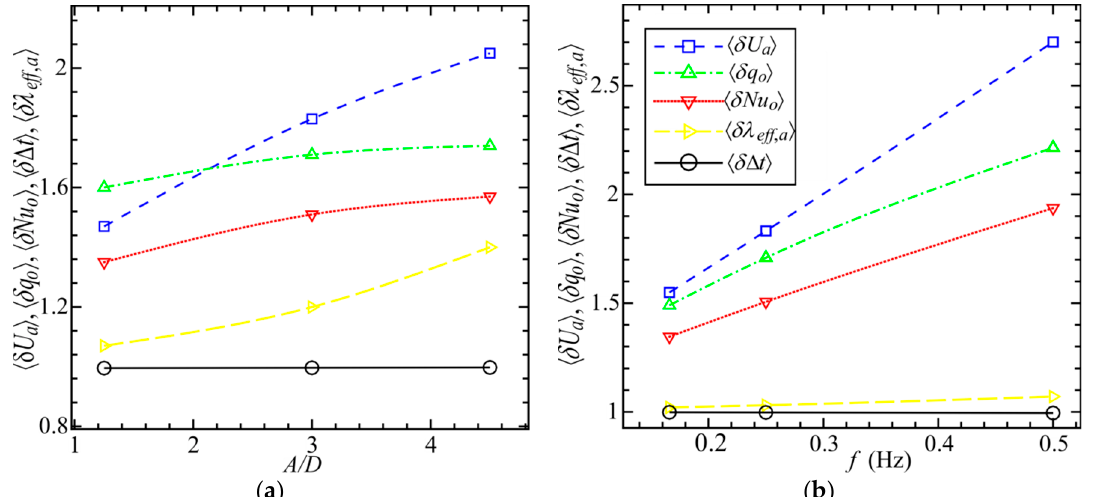
Figure 8. The effect of the pulsations on the flow and heat transfer characteristics averaged over space and time. ( a ) Variation of the velocity ratio δ U a = U a , p / U a , st , heat flux ratio δ q o = q o , p / q o , st , Nusselt number ratio δ Nu o = Nu o , p / Nu o , st , temperature difference ratio δ Δ t = Δ t p / Δ t st , and effective thermal conductivity ratio δλ eff , a = λ eff , a , p / λ eff , a , st with A / D at f = 0.25 Hz. ( b ) Variation of δ U a , δ q o , δ Nu o , δ Δ t , δλ eff , a with f at A / D = 3.